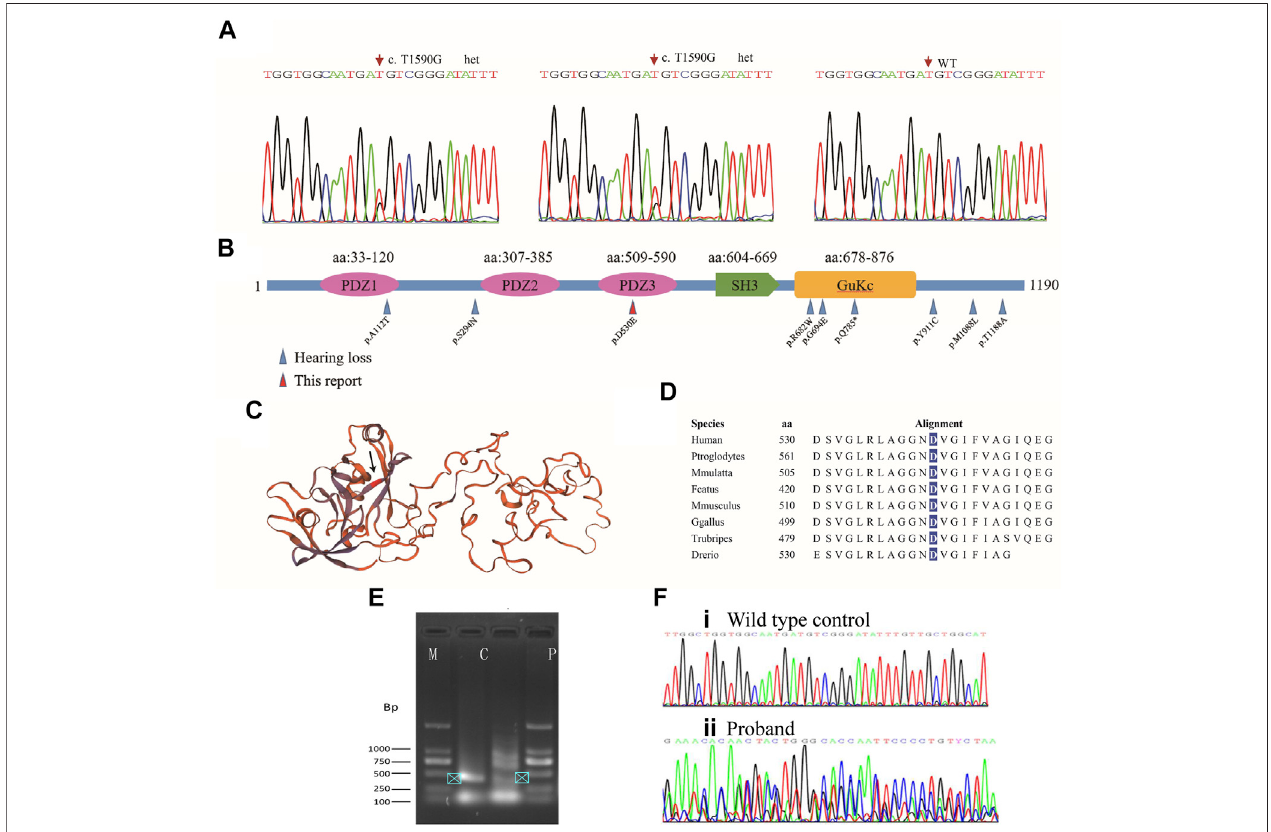
FIGURE3| Mutationanalysisof TJP2 . (A) Sangersequencingchromatogramsshowheterozygousvariantsintheaffectedsonandmother. (B) All TJP2 mutations curated in HGMD aremapped tothe encoded TJP2 protein;Blue arrows: Variants detectedin cases with hearing-loss;Red arrow: p.D530E inthe PDZ3 motif detected in the study. Another variant (p.A112T) that caused hearing loss is mapped to PDZ1 motif. (C) Schematic of the TJP2 three-dimensional protein structure, the p.D530E position is indicated by an arrow. How the variants in PDZ motifs affect the protein structure are currently unknown. (D) The p.D530 residue is evolutionarily conserved from zebra fi sh to human. (E) Agarose gel electrophoresis shows PCR products of TJP2 mRNA between c.1307 and 1712. M, marker; C, normal control sample; P, patient ’ s sample. (F) Sanger sequencing chromatograms show the TJP2 cDNA sequencing from normal control (i) and patient sample (ii) .